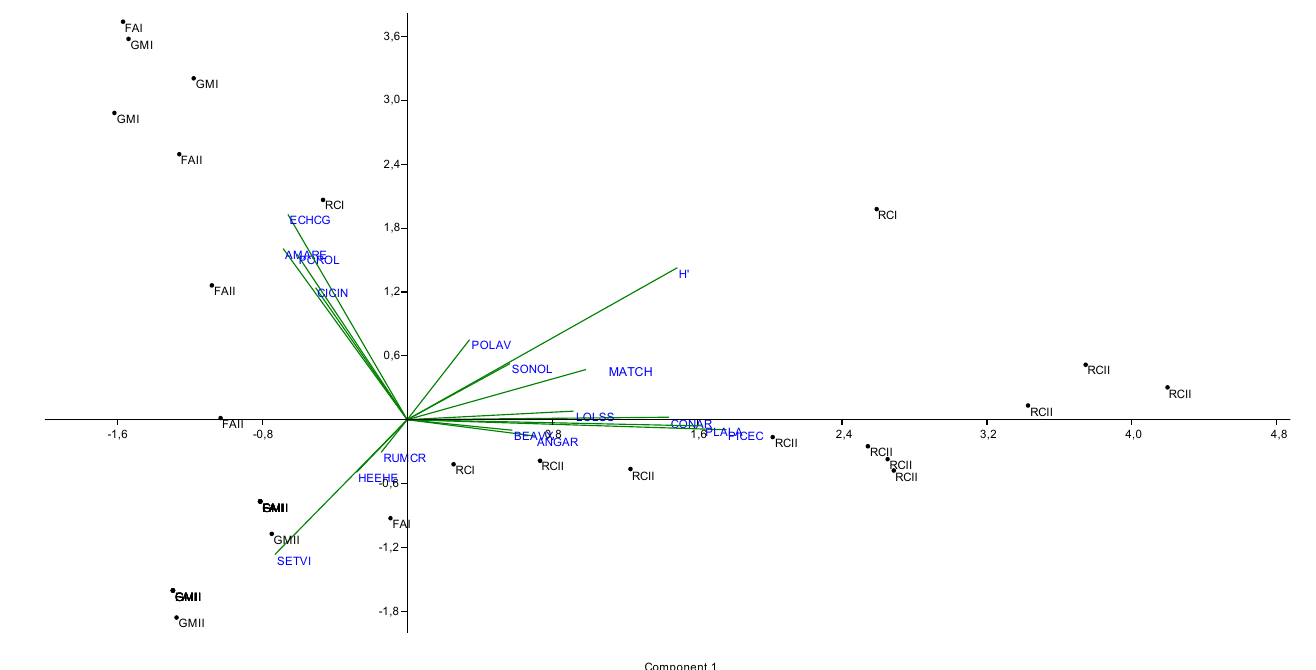
Figure 2. PCA biplot ordering the experimental trials relative to weed frequency and Shannon diversity index (H’). FA, fallow; GM, green manure; RC, in-line/roller crimper.